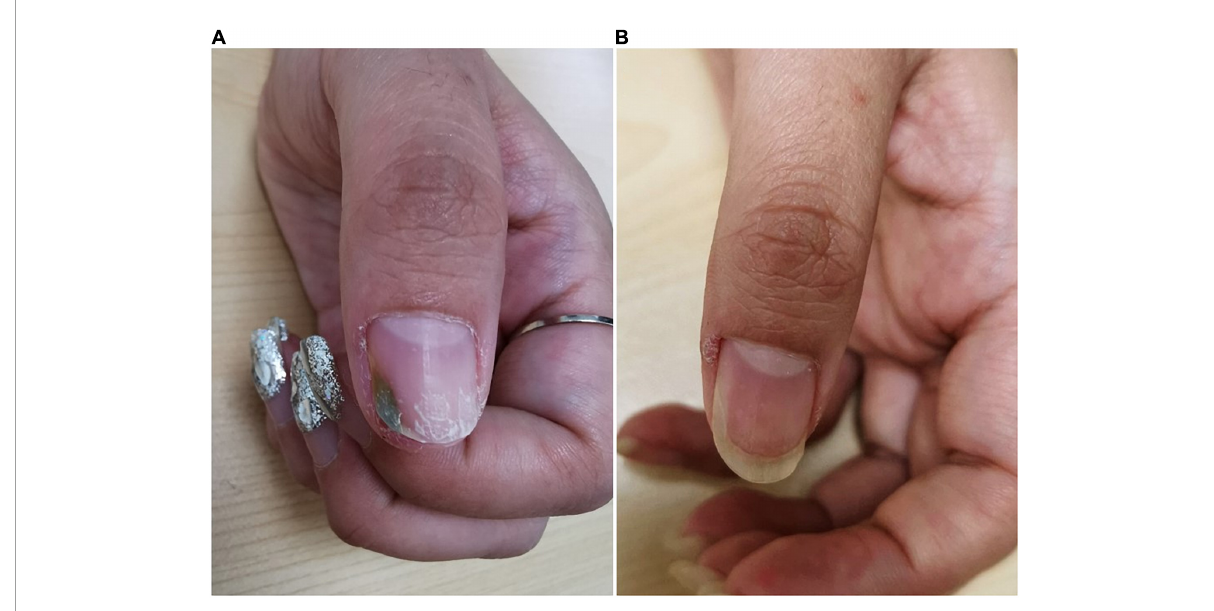
FIGURE1 Clinical image of Case 1. (A) Nail plate of a patient with trauma-related GNS at initial visit. (B) Subsided lesions at 3 months following topical antibiotic